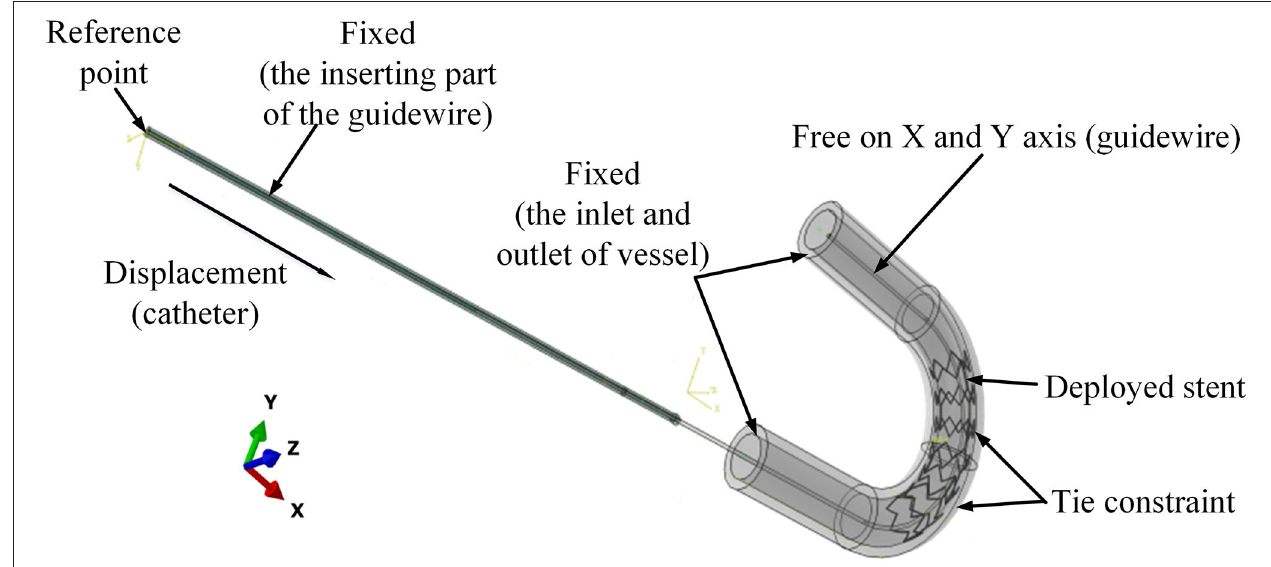
FIGURE 7 | Boundary conditions for the FE model of catheter-stent-vessel configuration (with curvature radius of 10mm).